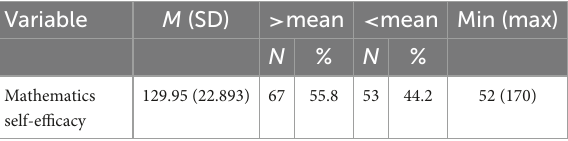
TABLE 2 Description of students’ mathematics self-efficacy. Variable